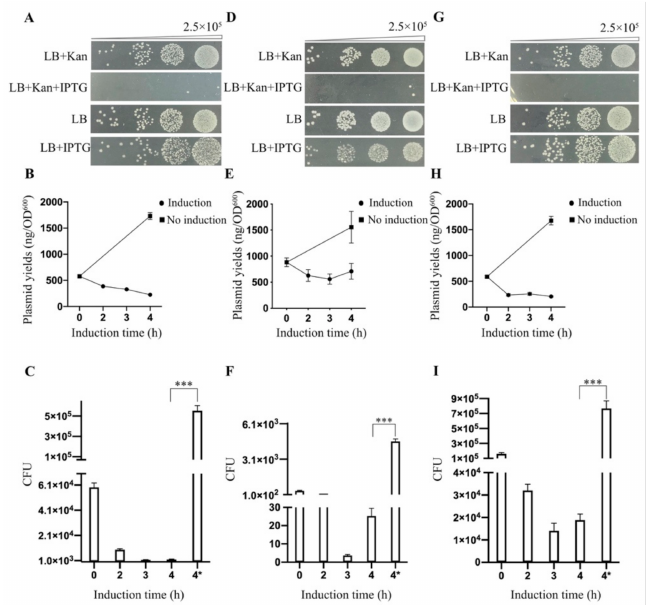
Figure 1. Expression of prokaryotic Argonaute proteins (pAgos) in E. coli BL21(DE3). ( A ) Spot plating assay for the effect of TtAgo expression on the host cell genome and its expression vector degradation. Cells were grown with or without isopropyl β -D-thiogalactopyranoside (IPTG) as noted. The upper panels were grown on Luria-Bertani broth (1% ( w / v ) NaCl, 1% ( w / v ) Tryptone, 0.5% ( w / v ) Yeast Extract, pH 7.0) plates supplemented with kanamycin, while the bottom was LB plates without kanamycin. ( B ) Plasmid yields of TtAgo expression vector in BL21 (DE3) at different times (2, 3, and 4 h) post-IPTG induction and before induction (0 h). Means and standard deviations from three biological replicates, error bars represent the mean ± s.d. ( C ) Colony-forming units were determined after plasmids recovered from before induction (0 h), different time points (2, 3, and, 4 h) of post-IPTG induction and without induction (the last column labeled as 4* represents 4 h of growth without IPTG induction) were re-transformed into E. coli BL21 (DE3) (means and standard deviations from three independent biological replicates, p < 0.05, p < 0.01, *** p < 0.001) ( D ) Spot plating assay for the effect of NgAgo expression on host cell genome and its expression vector degradation. ( E ) Plasmid yields of Natronobacterium gregoryi (NgAgo) expression vector in BL21 (DE3) at different times (2, 3, and 4 h) post-IPTG induction and before induction (0 h) as noted in ( B ). ( F ) Colony-forming units were determined after plasmids recovered from before induction (0 h), different time points of post-IPTG induction and without induction as noted in ( C ). ( G ) Spot plating assay for the effect of